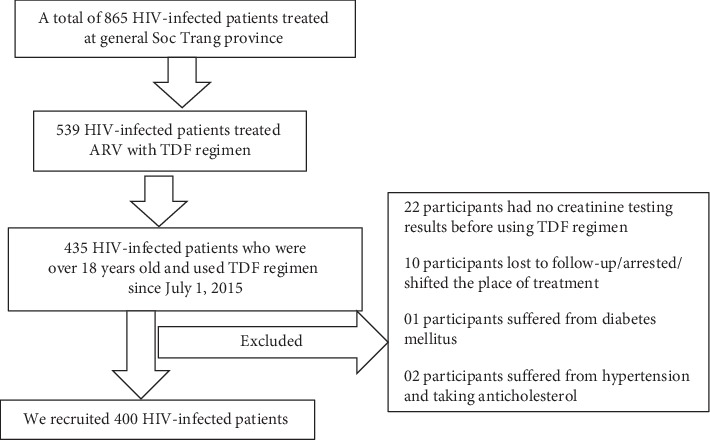
Enrollment of participants in Soc Trang, Vietnam.